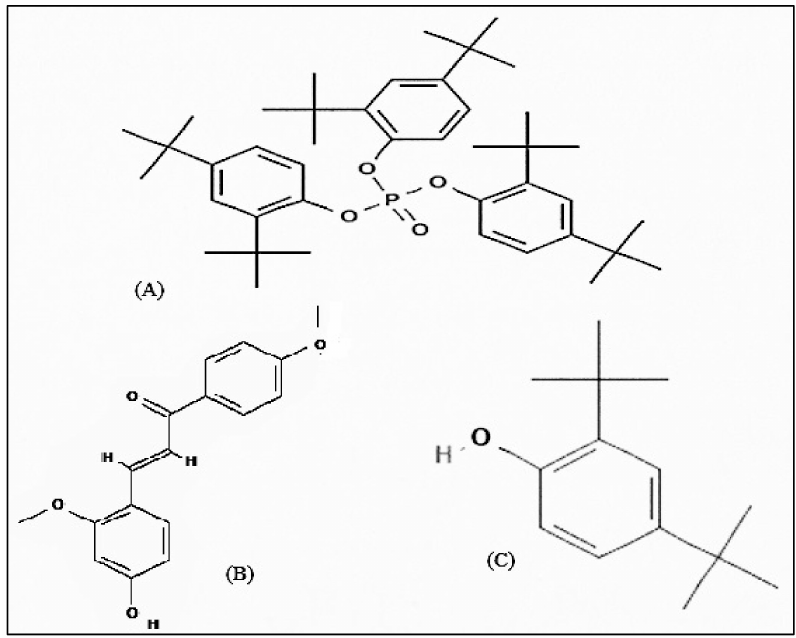
Figure 13. Chemical structure of isolated compounds: ( A ) Tris (2,4-di- tert -butylphenyl), ( B ) (4- Hydroxy-2,4 (cid:48) -dimethoxychalcone), and ( C ) (2,4-di- tert